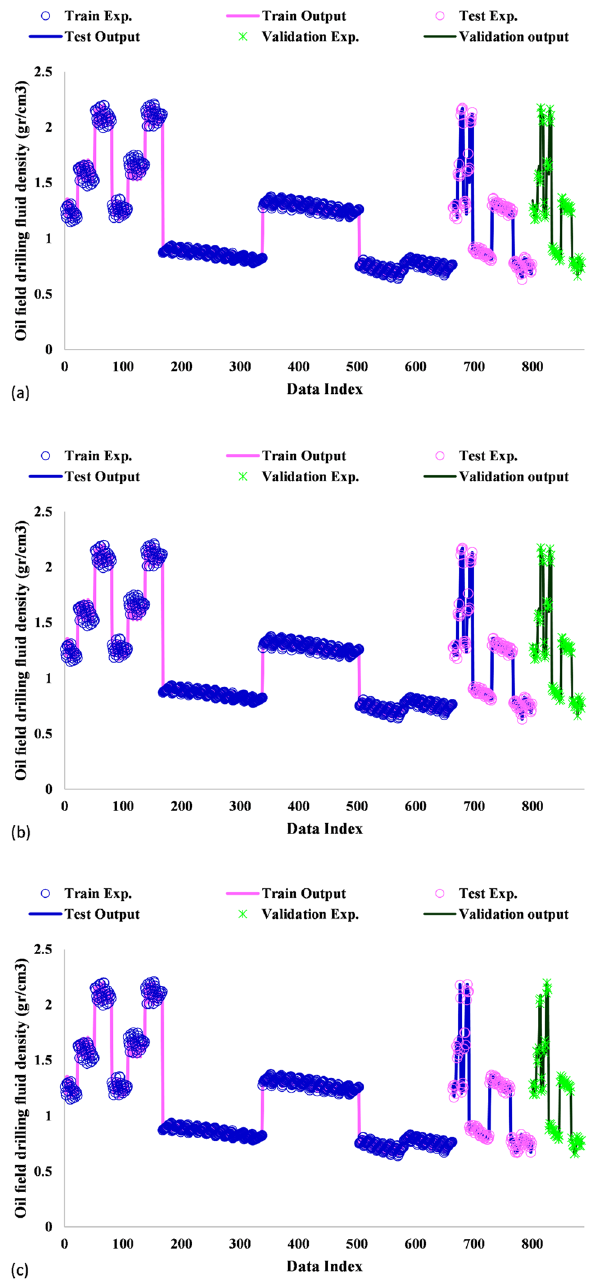
Figure 4. A comparison between the drilling fluid density obtained by ( a ) GA-LSSVM, ( b ) ICA-LSSVM, and ( c ) PSO-LSSVM models and the experimental values at the training, validation and testing